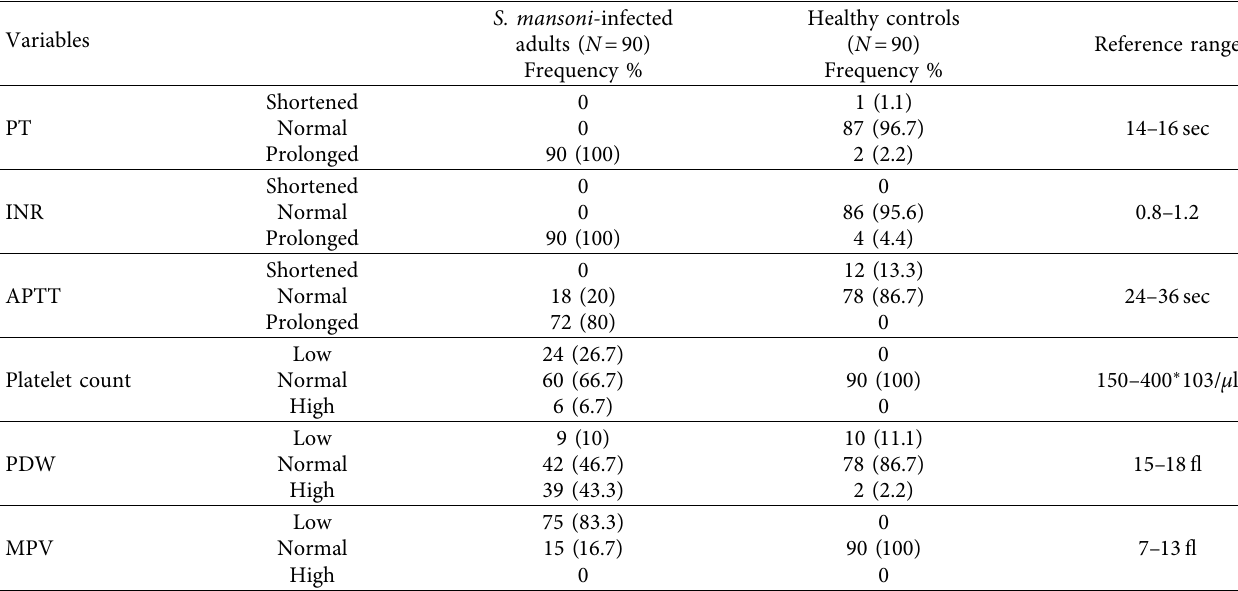
Table 2: Basic coagulation profiles and platelet parameters of the study participants and healthy controls.